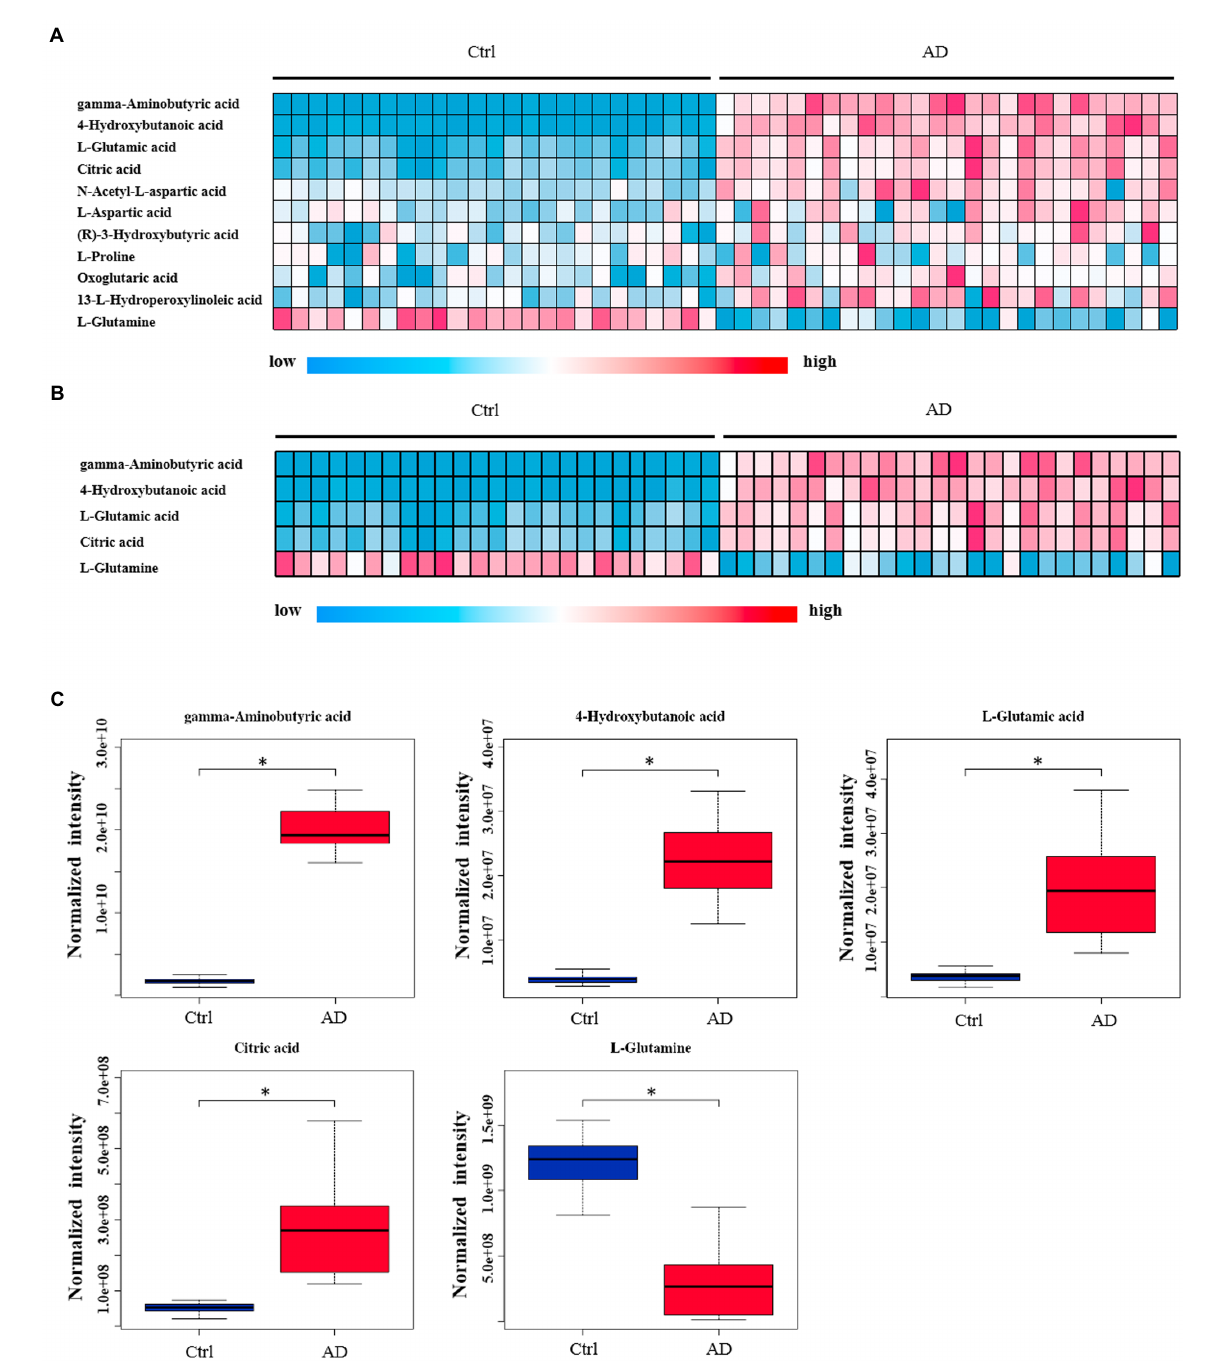
FIGURE 4 Heat map and box plot of important metabolites related to alcohol dependence. (A) Heat map of 11 metabolites screened from six signal pathways. (B) The metabolite heat map screened according to heat map A with a small difference within the group (with consistent color within the group). Columns represent samples, and rows represent metabolites. (C) Box plot of the selected five metabolites. Ctrl: control group; AD: alcohol dependence group. * p <